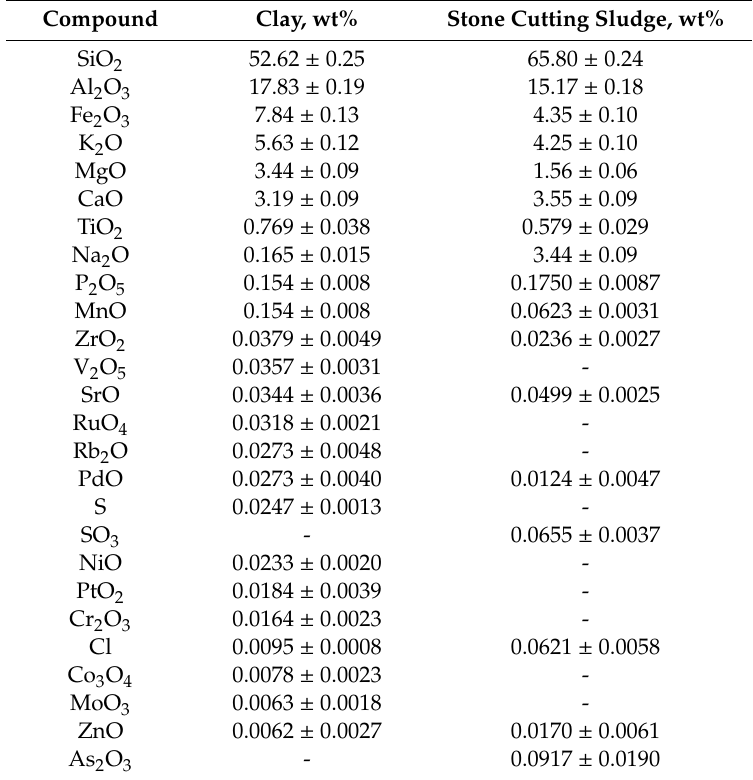
Table 4. X-ray fluorescence of the clay and the stone cutting sludge